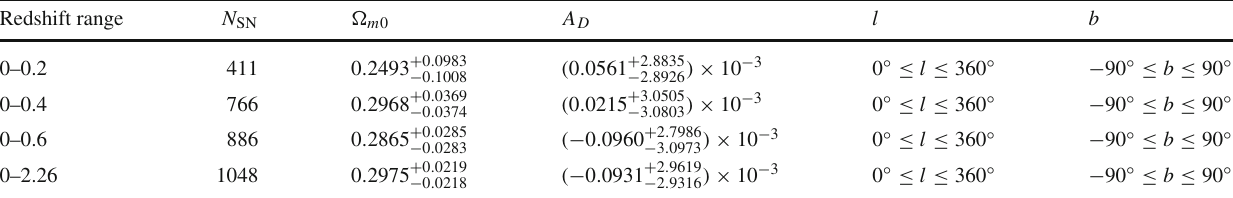
Table 2 The redshift range, the number of SNIa, and the constraints on (cid:8) m 0 , the dipole magnitude A D , and the dipole direction ( l , b ) . See the text for